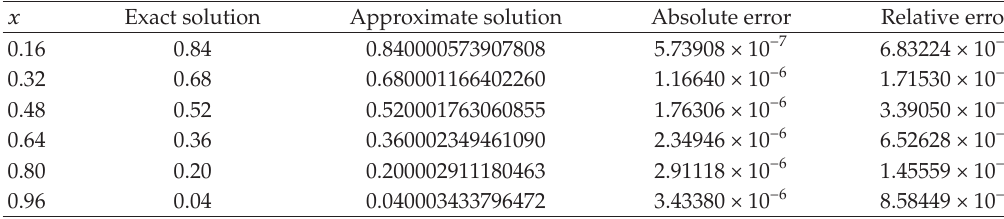
Table 7: Numerical results for Example 5.4.